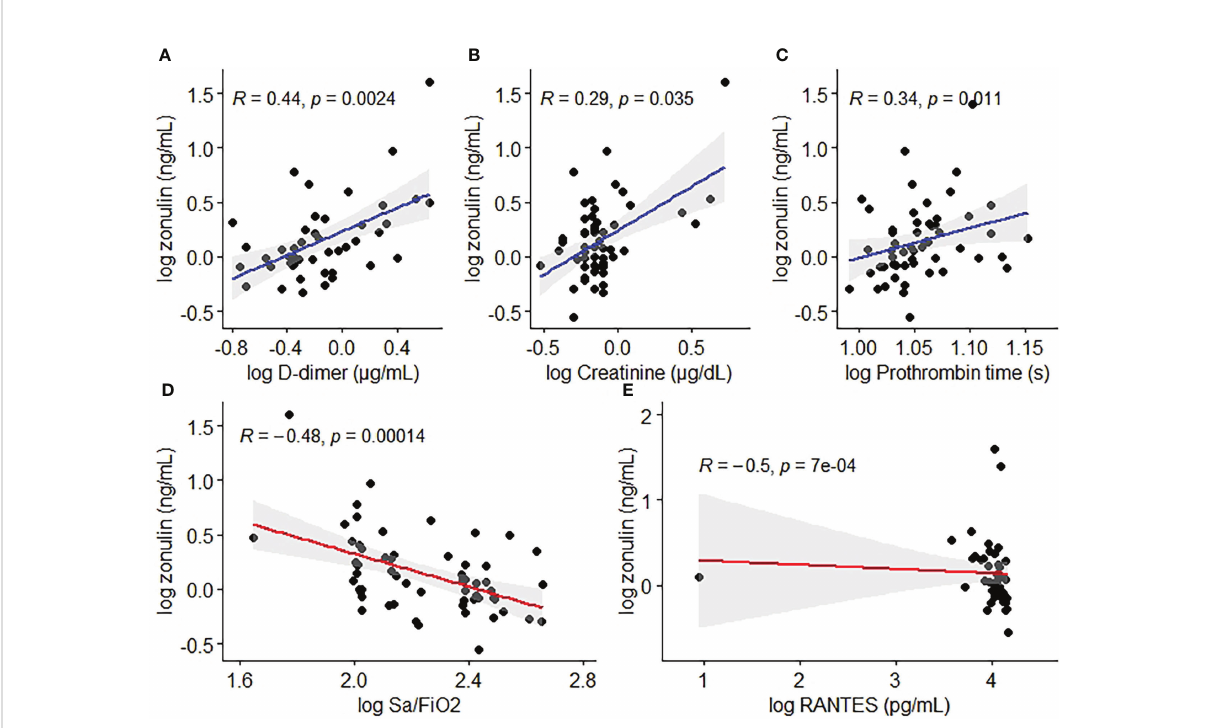
FIGURE 1 Scatterplots depicting signi fi cant correlations between zonulin and D-dimer (A) , Creatinine (B) , Prothrombin Time (C) , Sa/FiO 2 (D) and RANTES (E)